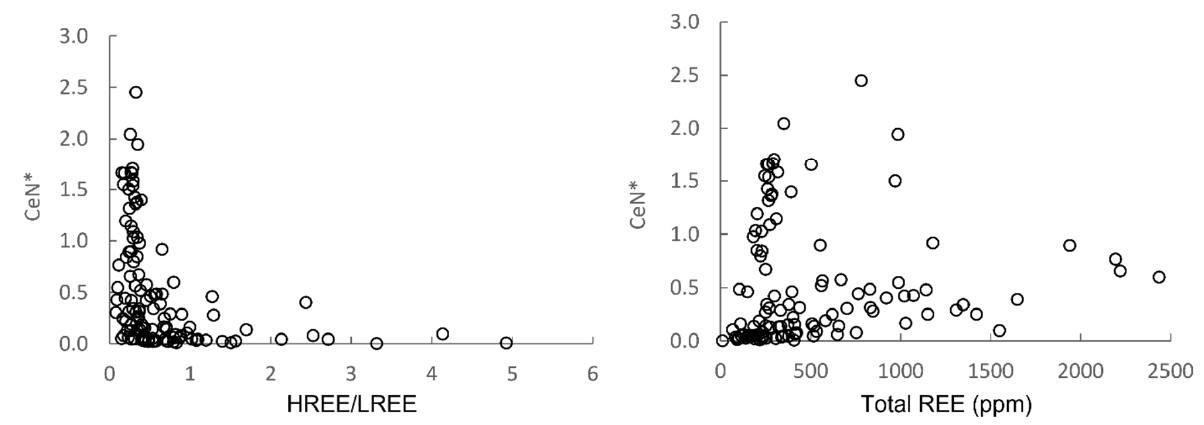
Figure 4. Plots of REE anomalies Ce ( left ) and Eu ( right ) from core samples. Ce N is the ratio of the concentration of Ce in the sample to Ce in the upper continental crust (UCC). Ce N * and Eu N * are calculated using the equation(s) from Dai and others, 2016 [5] where Ce N * = 0.5La N + 0.5Pr N and Eu N * = 0.5Sm N + 0.5Gd N .